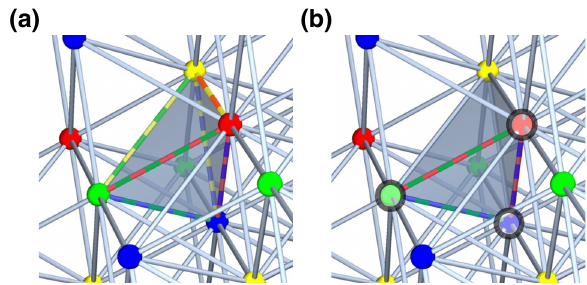
FIG. 31. (a) A Z -gauge flux due to an isolated X error (shaded tetrahedron) consists of six edges of different colors. (b) The restricted gauge flux, which is measured (assuming no errors occur during the measurement), excludes edges incident to Y